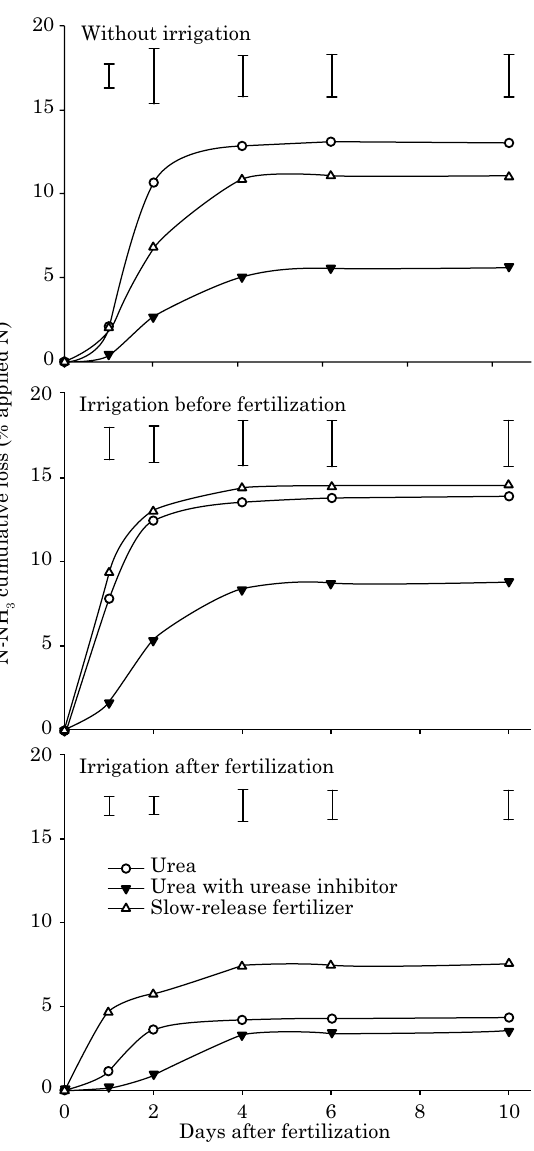
figure 3. cumulative n loss by ammonia volatilization from different n fertilizers broadcast on maize without irrigation, with irrigation before fertilization and irrigation after fertilization. Vertical bars indicate least significant difference by the Tukey test at 5